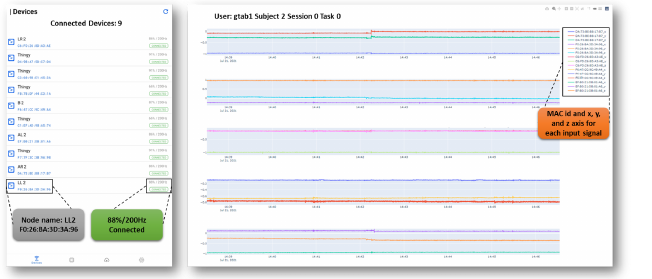
Figure 9. GPSJack Android mobile application running on the tablet: node connection and data visualization.